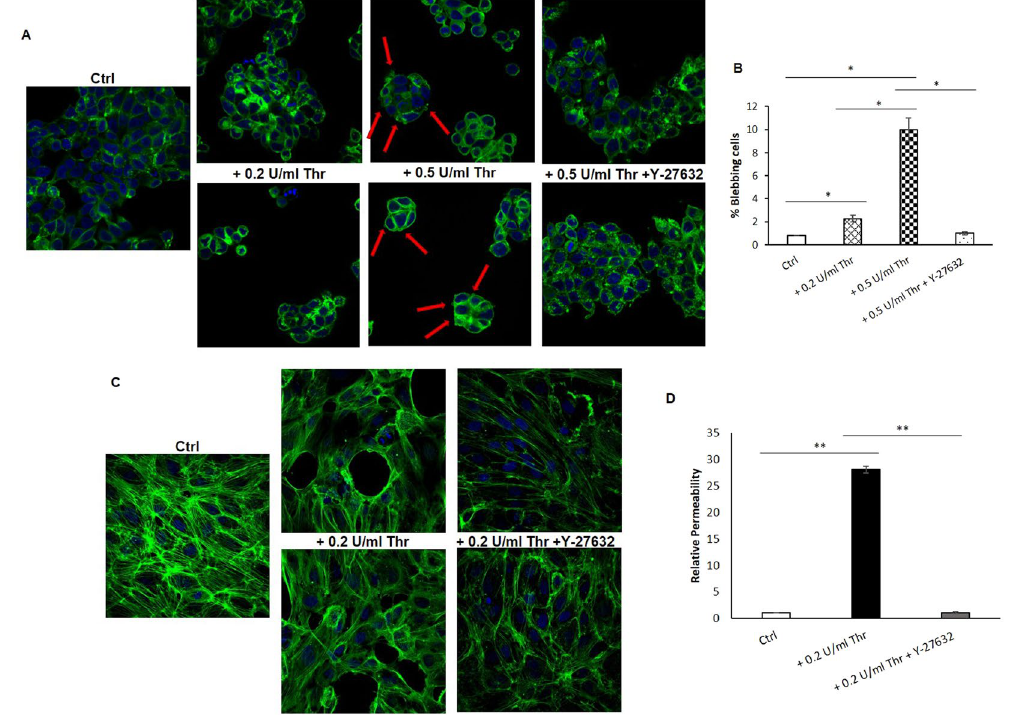
Figure 7. Thrombin is a key mediator of effects induced by SW620Exos in target cells. ( A ) Confocal micrographs show the ability of Thrombin to induce in SW480 cells the transition from an elongated to an amoeboid phenotype in a dose-dependent manner. Moreover, we found that the addition of Y-27632 was able to revert the effect induced by Thrombin, indicating the involvement of RhoA pathway. Except that for the Control (Ctrl: no treated cells), two representative fields are reported for each analysed condition. Cells were stained with Actin green (green) and nuclear counterstaining was performed using Hoescht (blue). ( B ) Percentage of SW480 blebbing cells obtained by counting 5 different fields for each reported condition. ( C ) Confocal micrographs show the ability of Thrombin to alter the HUVEC monolayer. As for SW480 cells, we found that the addition of Y-27632 was able to revert the effect induced by Thrombin. Except that for the Control (Ctrl: no treated cells), two representative fields are reported for each analysed condition. Cells were stained with Actin green (green) and nuclear counterstaining was performed using Hoescht (blue). ( D ) Dextran permeability assay of HUVEC monolayer after treatment with Thrombin and Thrombin + Y-27632. Values reported in the graphs are the mean ± SD of three independent experiments. Statistical significance was calculated as indicated by the horizontal lines; * p ≤ 0.05, ** p ≤ 0.01; Thr: